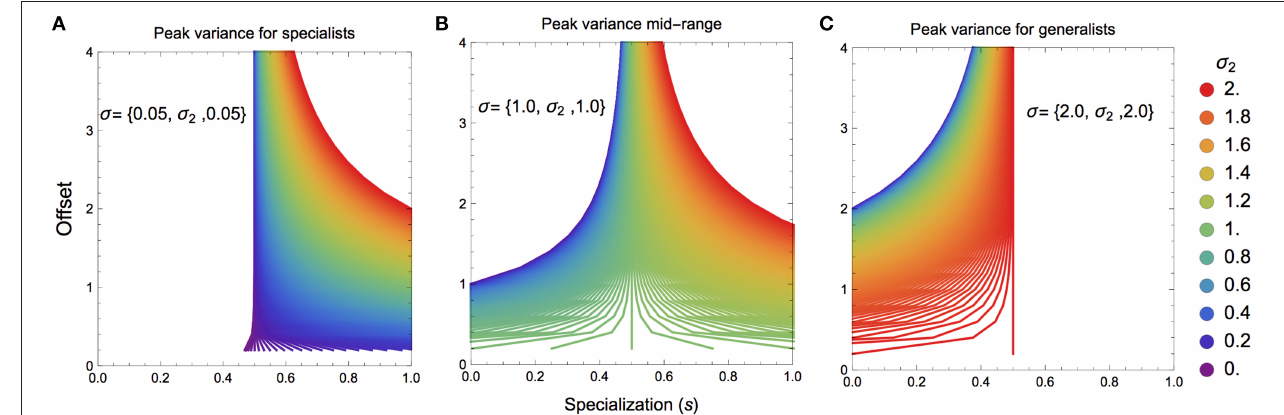
FIGURE 2 | Maximal consumer isotopic variance ˆ s k over the specialization index s as a function of mixing space geometry. (A,B) If the targeted prey has a higher than average isotopic variance, the maximum consumer niche width will lie toward consumer specialization. (B,C) If the targeted prey has a lower than average isotopic variance, the maximum consumer niche width will like toward consumer generalization. Panels (A–C) as the mean offset of the targeted prey is farther from the centroid of the mixing space, the maximal consumer isotopic niche width tends toward s